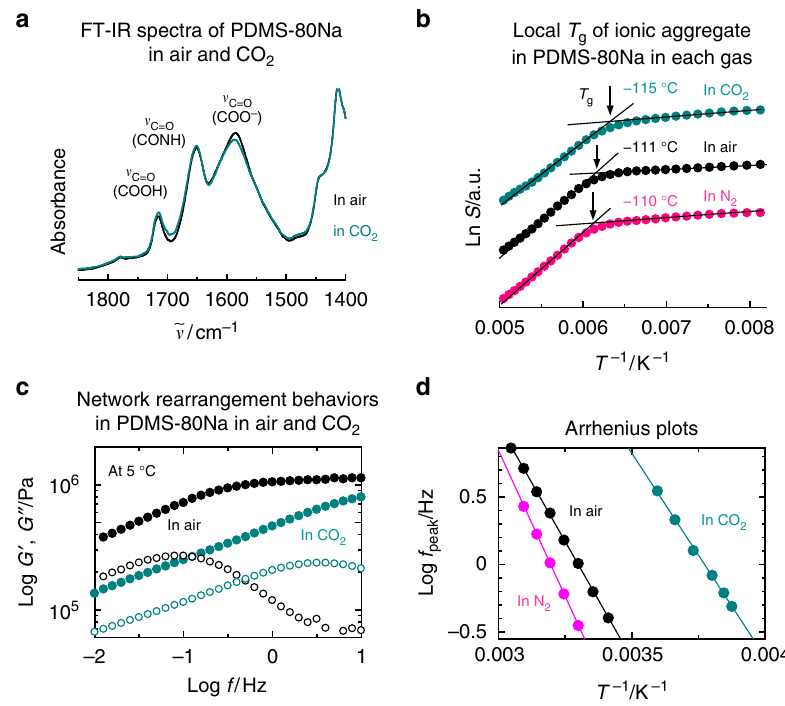
Fig. 3 Effect of CO 2 on ionic aggregate and network rearrangement. a FT-IR spectra of PDMS-80Na measured in air and in CO 2 . b Temperature dependence of the saturation factor ( S ) for PDMS-80Na in air, N 2 , and CO 2 . The in fl ection temperature represents the local T g of ionic aggregate. c Frequency sweep of storage modulus ( G ′ , solid symbols) and loss modulus ( G ′′ , open symbols) for PDMS-80Na measured at 5 °C in air and in CO 2 . The relaxation is assigned to rearrangement of ionic crosslinks. d Arrhenius plots of peak frequency of G ′′ for PDMS-80Na in air, in N 2 , and in CO